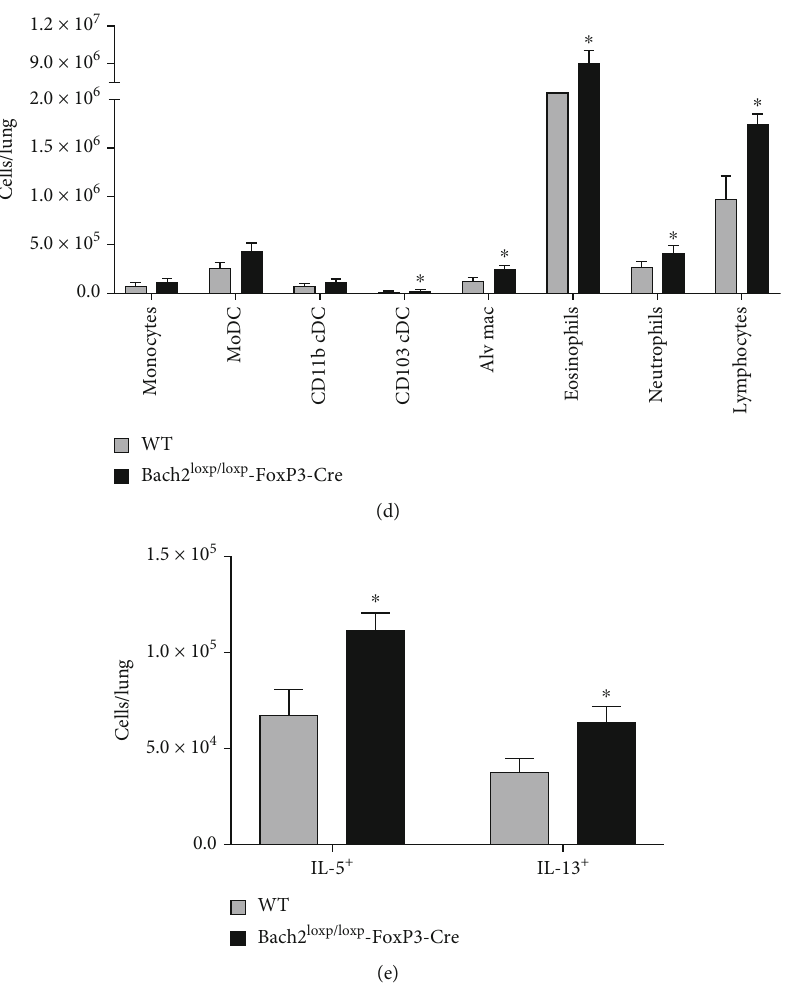
Figure 5: Bach2 is required for Tregs to control T 2 immunity in lungs. WT and Bach2 loxp/loxp FoxP3-Cre mice were administered H Aspergillus melleus fungal protease intratracheally and lungs were harvested on day 15; mononuclear cells from lungs were analyzed by fl ow cytometry. (a) Frequency and numbers of Foxp3 +ve Tregs in the lungs. (b) Frequency of KLRG-1-, CXCR3-, CD103-, and ST2- positive Tregs in lungs. (c) MFI levels for BATF, IRF4, and GATA3 staining in Foxp3 +ve Tregs. (d) Numbers of in fl ammatory cell subsets in the lungs. (e) Cells from the lung were stimulated for 6hrs in vitro with heat-inactivated fungal protease in the presence of Brefeldin A during the last 4 hrs, and cytokine production was measure by intracellular staining of IFN γ , IL-5, IL-13, and IL17 in CD4 T cells. This experiment was repeated two times with similar results, 4-6 mice per group. ∗ p < 0 : 05